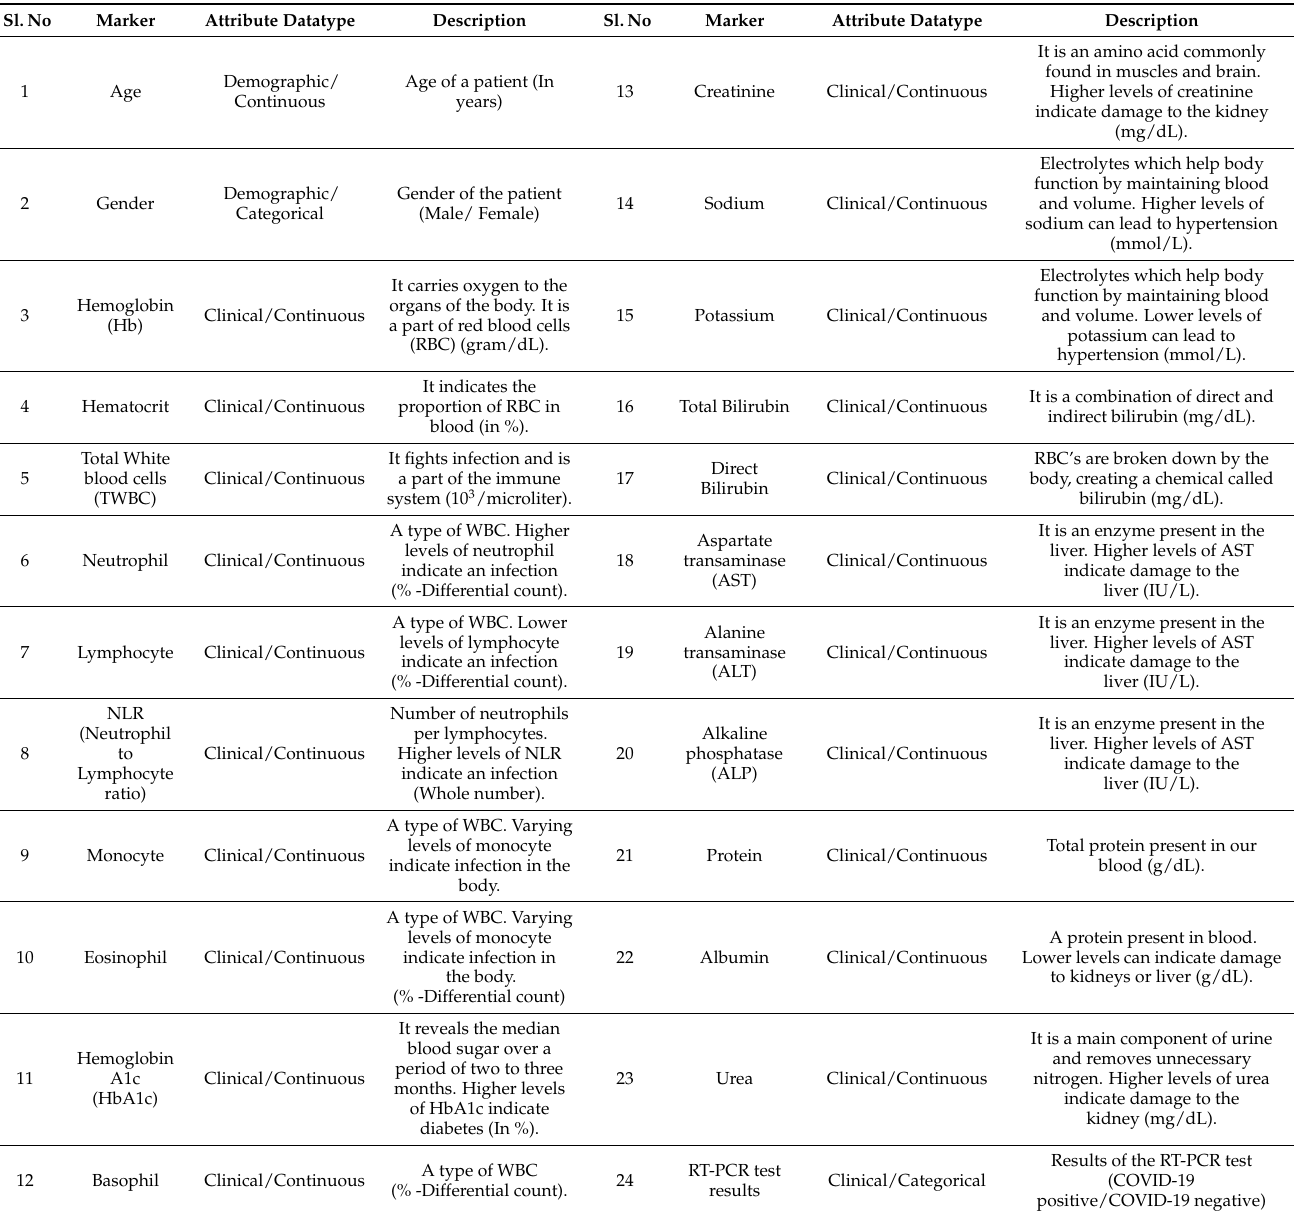
Table 1. Clinical markers present in the